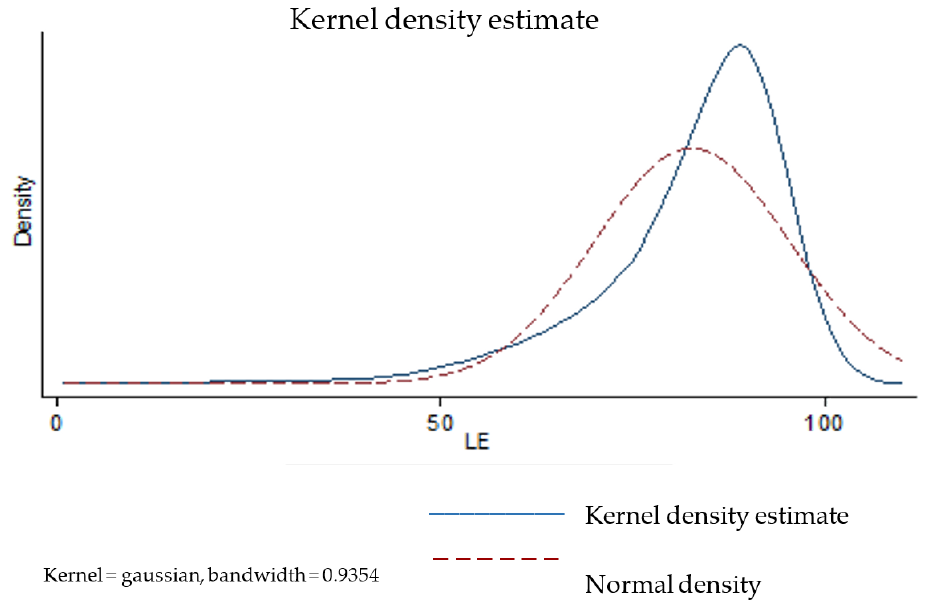
Figure 1. Kernel density estimate for Spain.